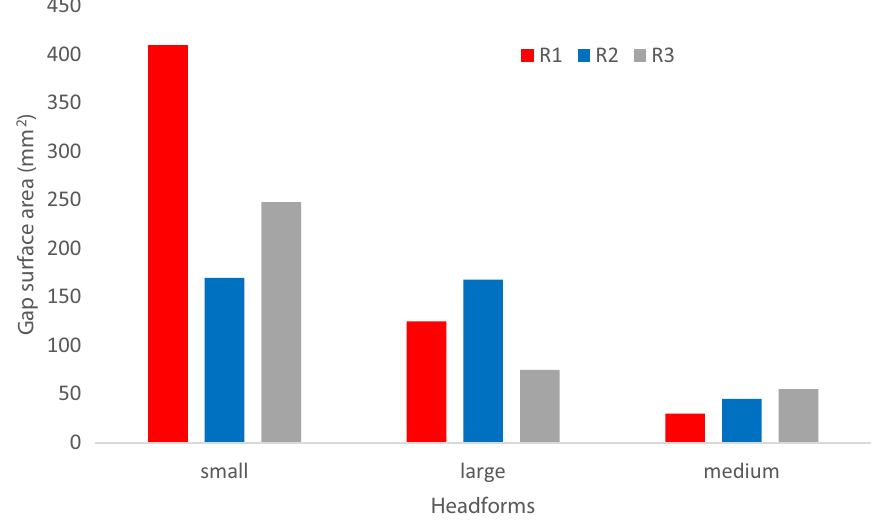
Figure 6. A plot showing the variation of gap surface area with different head-respirator combinations.